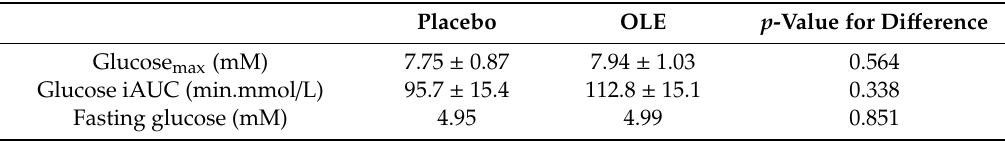
Table 1. Individual responses of the subjects after ingesting sucrose solution were tested by measuring blood glucose levels.